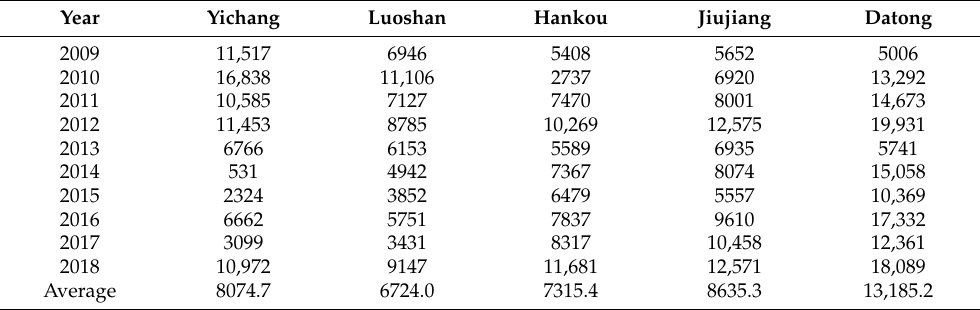
Table 3. The difference between the reconstructed maximum 1-day discharge and the observed maximum 1-day discharge after the full operation of the TGD from 2009 to 2018. If the difference is greater than 0, the TGD has reduced the maximum 1-day discharge during flood season. Difference = Q Re − Q Ob ; Q Re : reconstructed maximum 1-day discharge; Q Ob : observed maximum 1-day discharge.